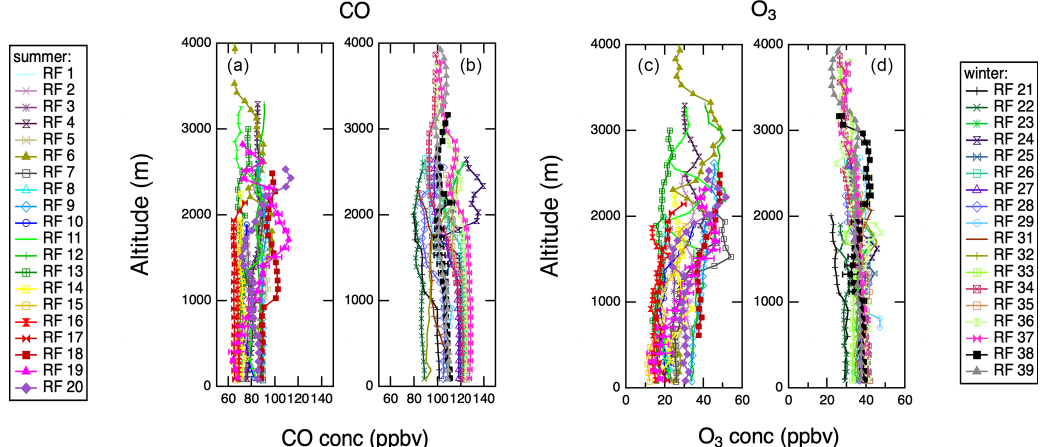
Figure 12. Vertical profiles of carbon monoxide and ozone measurements acquired during spiral profiles shown in Fig. S1. Representative error bars (1 σ standard deviations) are shown on 1d only for clarity. (a) CO, IOP 1. (b) CO, IOP 2. (c) Ozone, IOP 1. (d) Ozone, IOP 2.